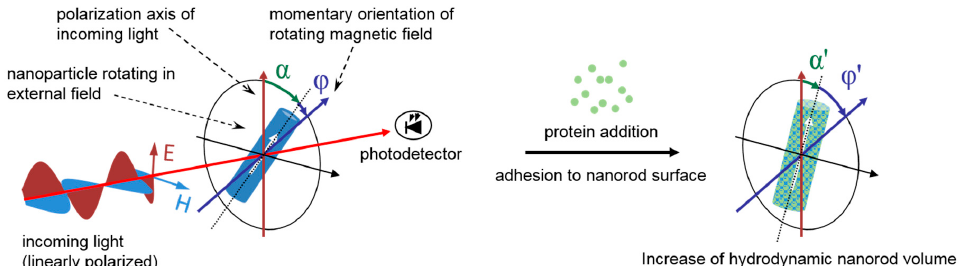
Figure 3. Measurement principle for detecting proteins in solution according to reference [121].